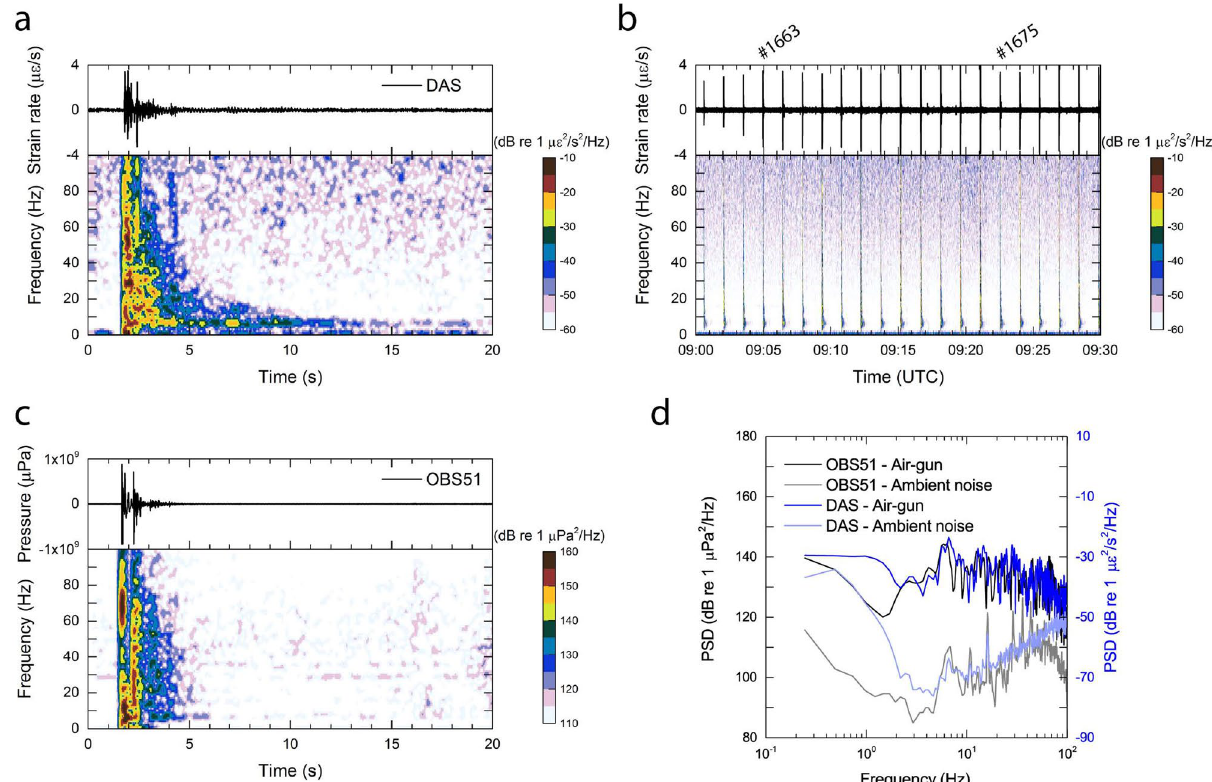
Figure 3. Comparison of hydroacoustic signals recorded by the DAS measurement and the co-located hydrophone. ( a ) Time series recording and its spectrogram of the DAS measurement at a cable length of 20.8 km, recording the air-gun shot number 1663 along the MR01 line. ( b ) A series of air-gun shots recorded by the DAS measurement at the same location of ( a ) at 09:00s UTC on 03 December 2019, when the ship approaching the Muroto cable and co-located two OBSs. A shot #1663 conducted at 09:04:56 UTC is magnified in ( a ). A following shot #1675 conducted at 09:22:32 UTC is also indicated. ( c ) Hydroacoustic signal originated from the same explosion of ( a ) recorded by a hydrophone of OBS51 displayed as the same form of ( a ). ( d ) Power spectral densities (PSDs) of the same signals of the DAS measurement and the hydrophone comparing with the ambient noise between the air-gun